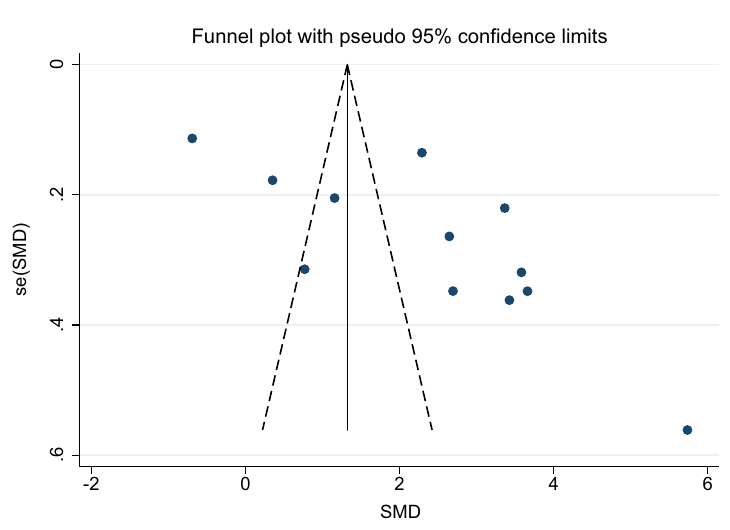
Figure 14. Funnel plot demonstrates the publication bias among 11 studies comparing the mean CRP level between patients with uncomplicated and healthy/febrile controls. SMD, standard mean difference; se, standard